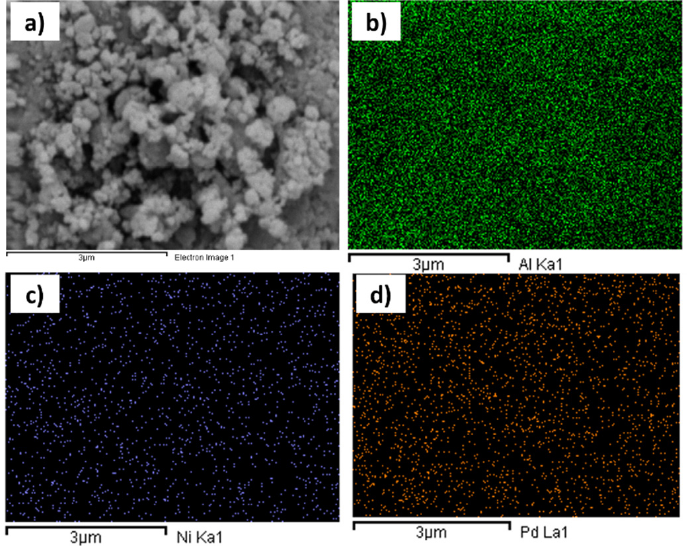
Figure 6. Energy-Dispersive X-ray images of AlNi1Pd1. ( a ) SEM image, ( b ) Al content, ( c ) Ni con- tent, and ( d ) Pd content.